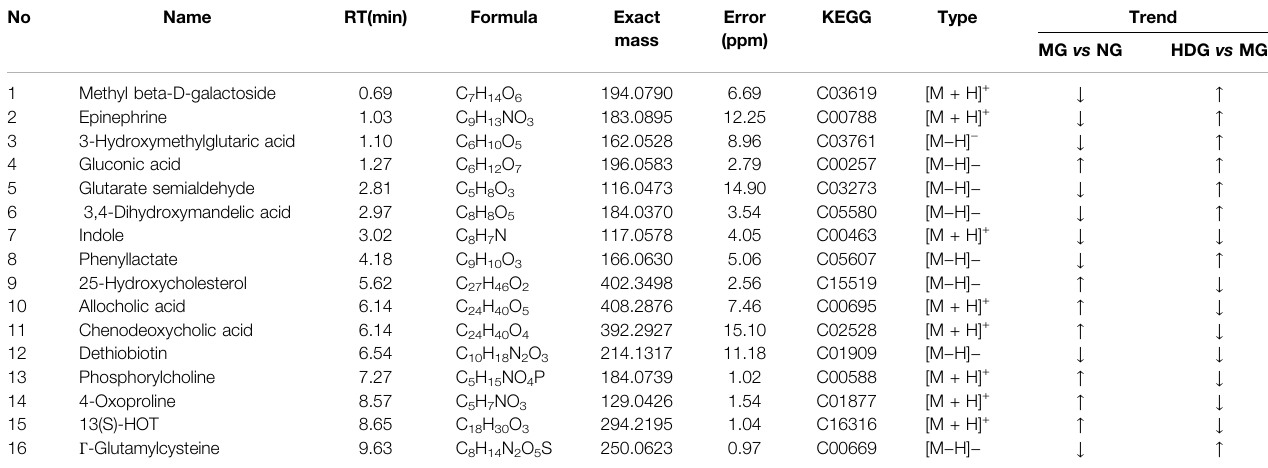
TABLE 2 | List and change trends of differential metabolites in the rats serum induced by ANIT.